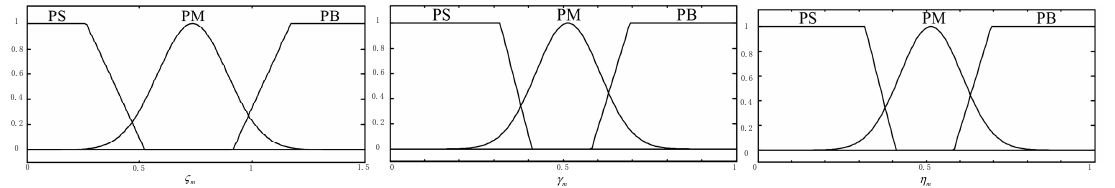
Figure 3. Fuzzy membership functions.